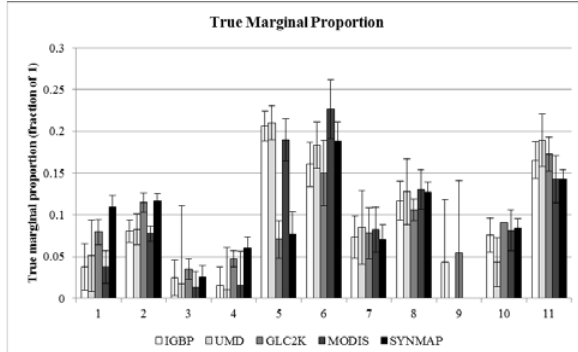
Figure 6. True marginal proportions of the land cover classes for each